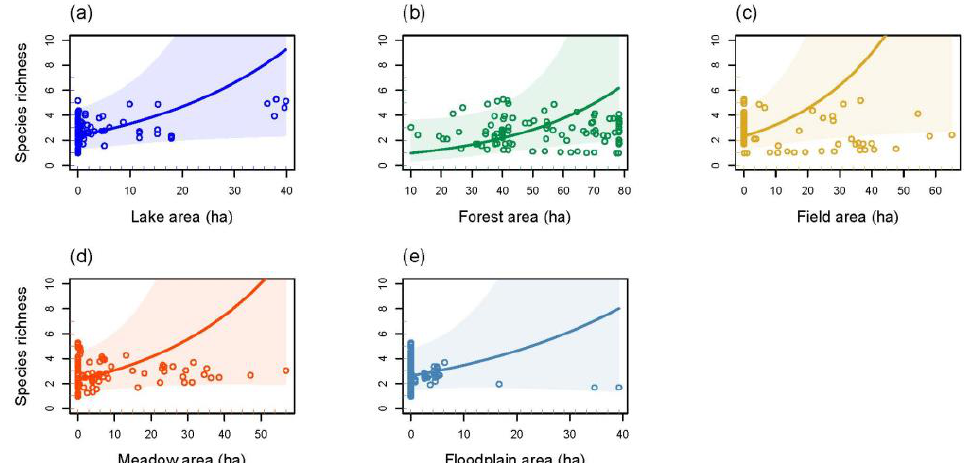
Figure 7. Visualizations of GLMM results revealing the relationships (solid line) between the land cover types (in hectares) and species richness at the mist-netting site level (dots): ( a ) Lake area, ( b ) Forest area, ( c ) Field area, ( d ) Meadow area, ( e ) Floodplain area. Similar to species richness, the index of total bat abundance was positively signifi- cantly affected by the area of lake and field and marginally affected by the area of forests affected by the area of young forests (1–40 years old; t = − 2.14) (Supplementary Material Figure S4b, Table